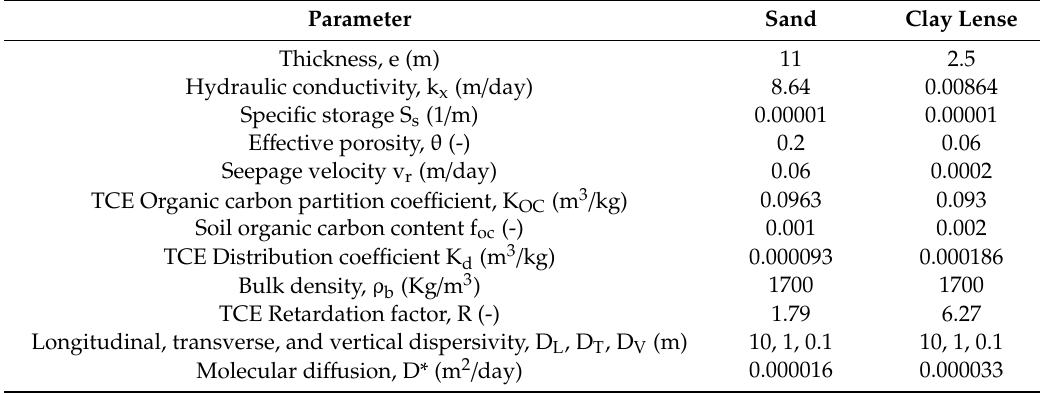
Table 2. Hydrogeological and chemical properties of aquifer and contaminants for the synthetic case.